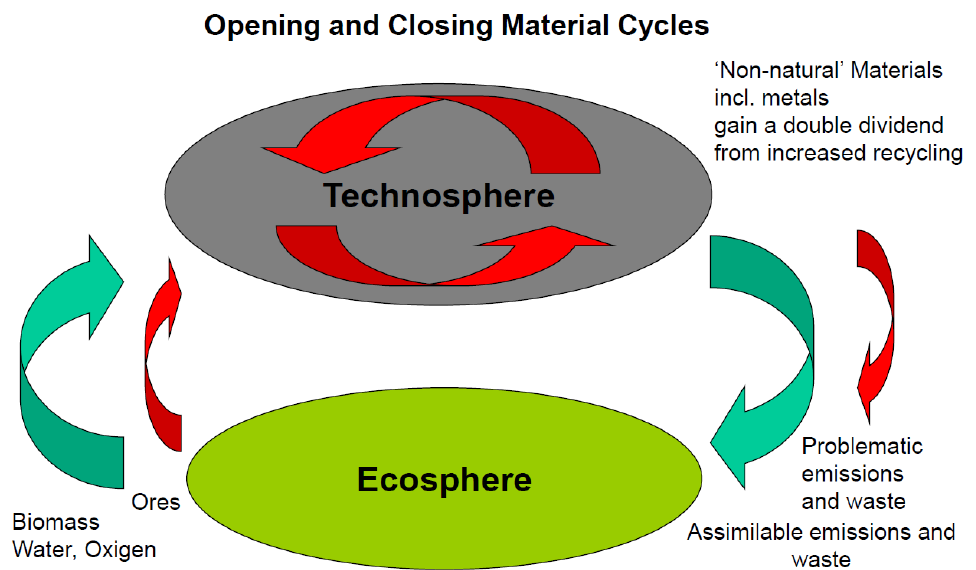
Figure 6. There are two different cycles with options of flow regulation, closing or opening. The cycle within technosphere is currently named as 'circular economy'. Another cycle exists between ecosphere and technosphere. It can be interpreted as a kind of metabolism: resource consumption, digestion/processing, excretion/waste/emissions (according to Gößling-Reisemann et al. [171]).